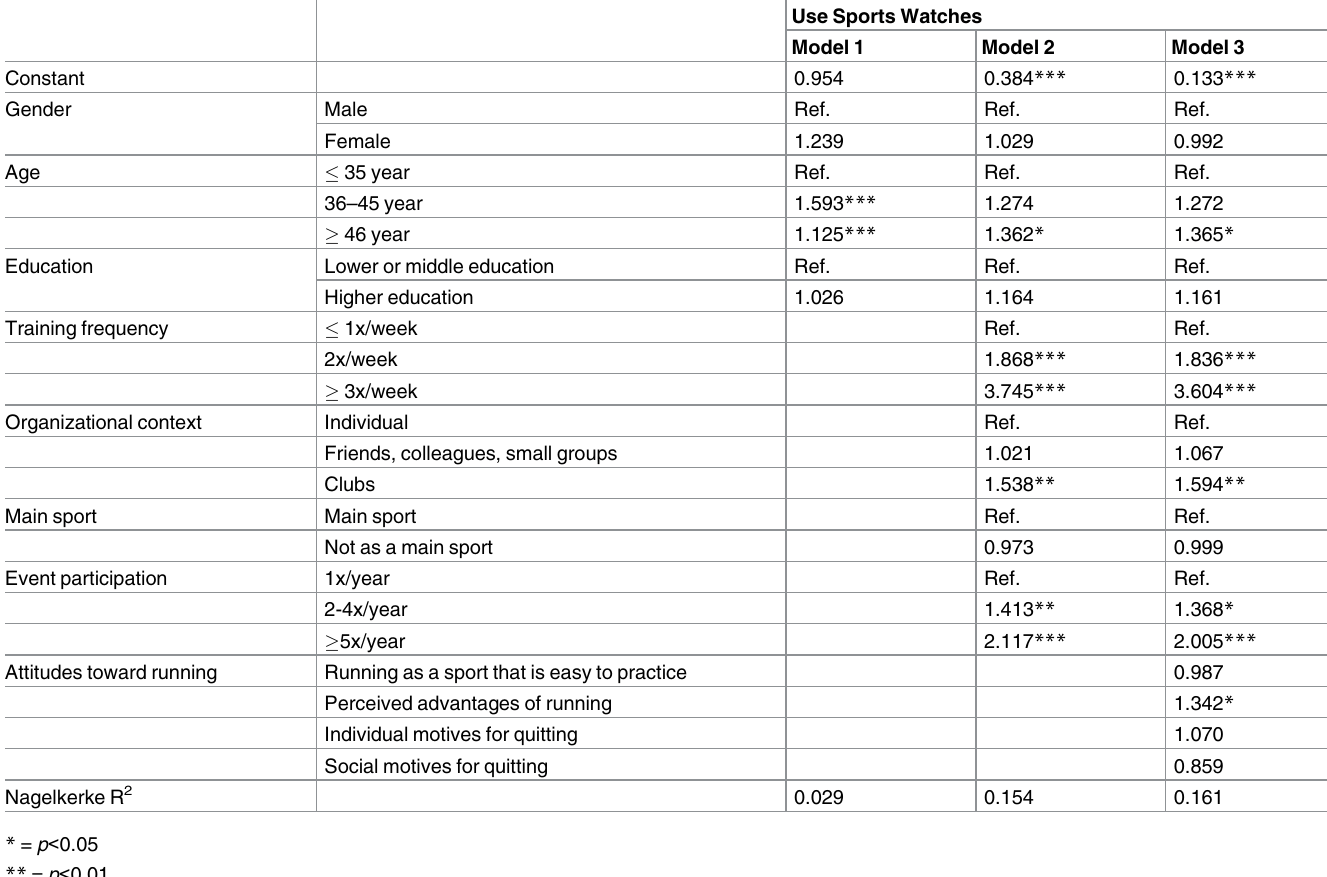
Table 6. Results of the binary logistic regression analysis for event runners’ usage of sports watches, in odds ratios (Exp ( β )) with regards to the referencegroup